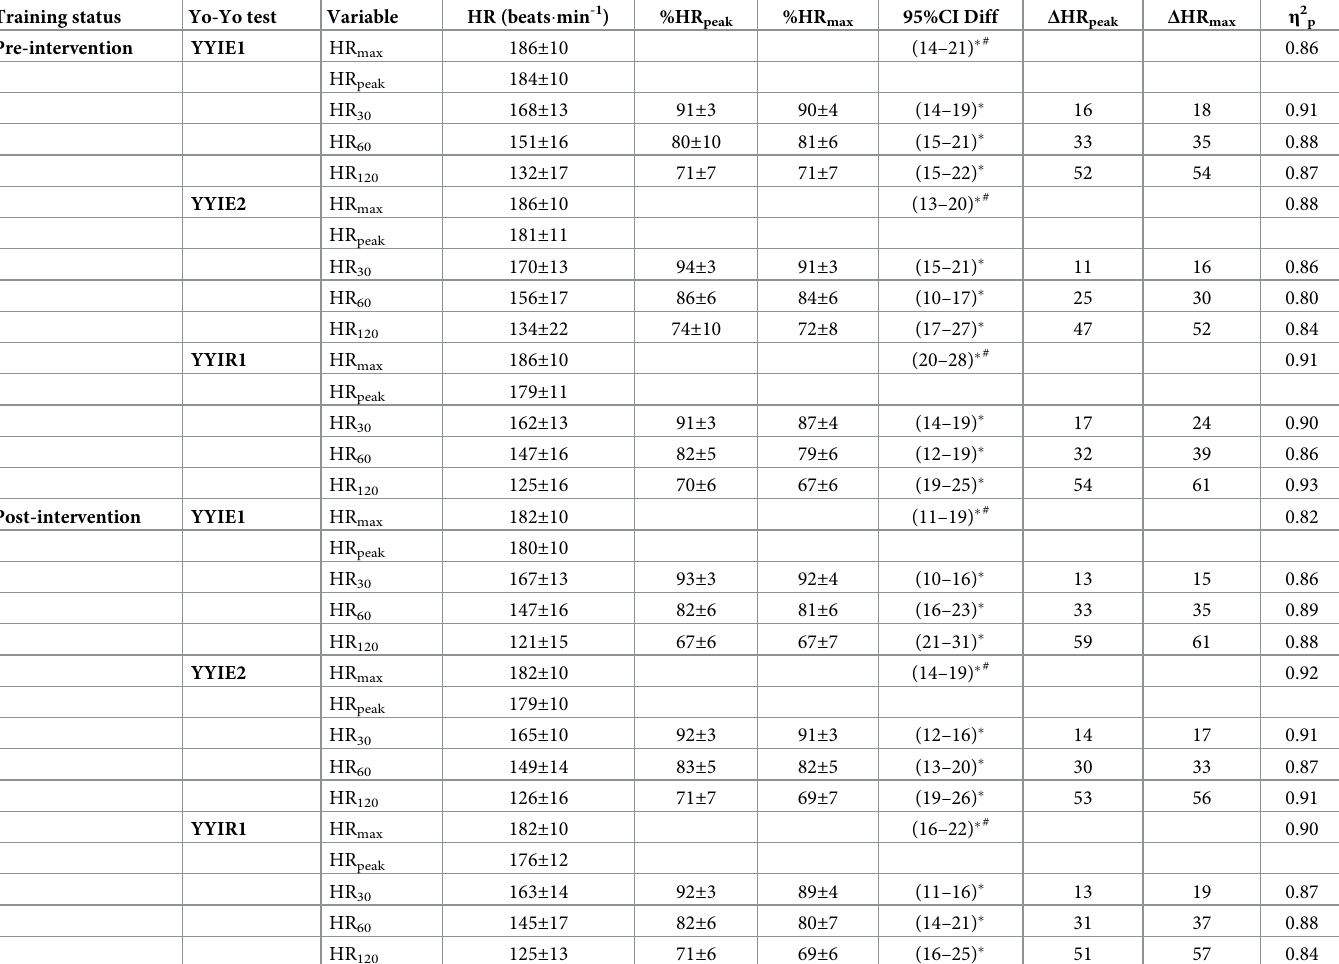
Table 2. Heart rate (HR) recovery values at selected recovery time points after the field tests and between their values differences pre- to post-training intervention. The HR values are reported as % of test peak HR (HR peak ) and individual maximal HR (HR max